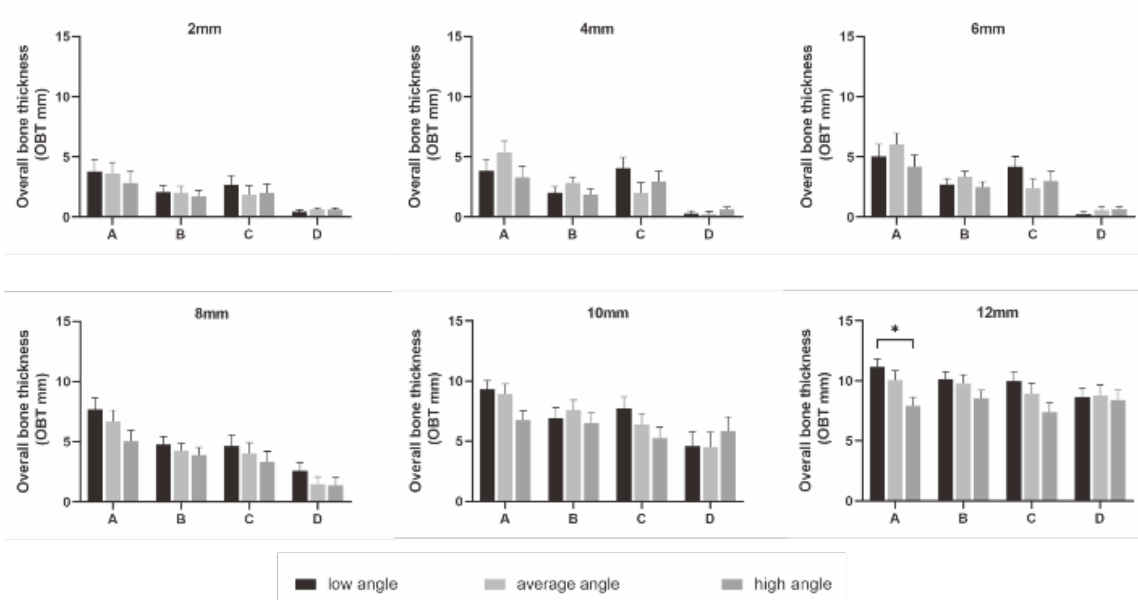
Figure 2. Comparisons of OBT among different facial types at each location. * p < 0.05.